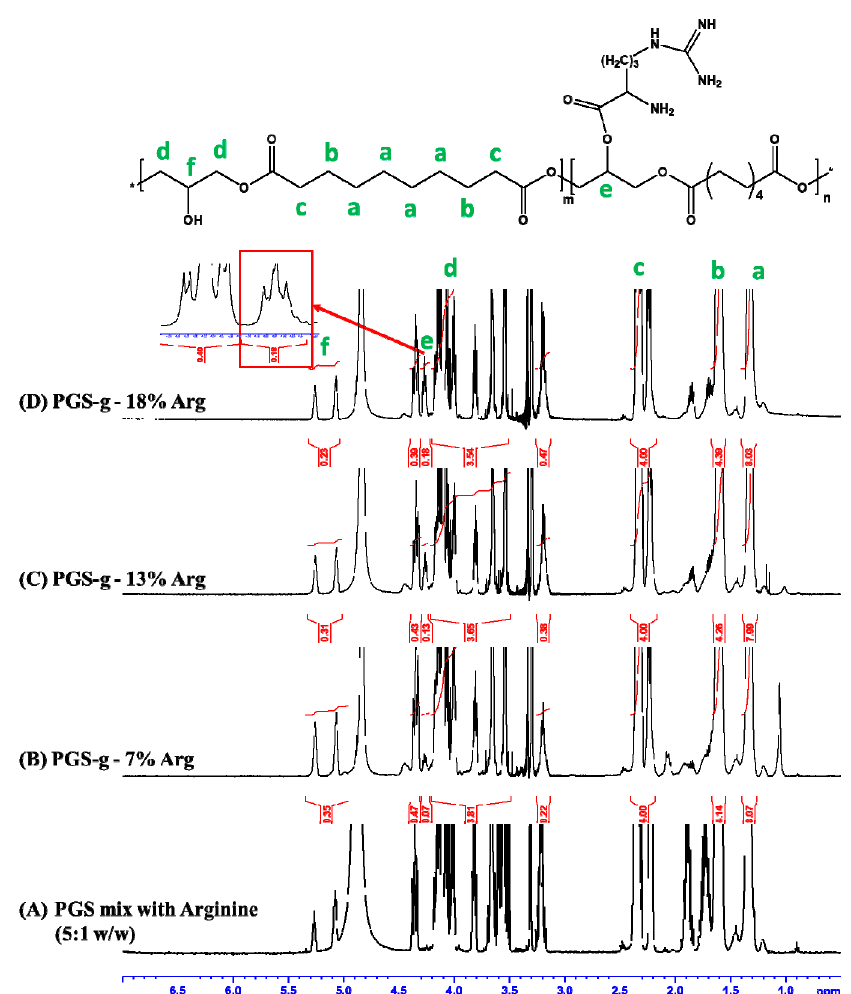
Figure 2. The relative positions and structural analyses of ( A ) PGS prepolymer mix with L -arginine (5/1 w / w ) and PGS-g-Arg prepolymers with the grafting content of ( B ) 7%, ( C ) 13%, and ( D ) 18% L -arginine, respectively on 1 H-NMR spectra (d-solvent: CD 3 OD).